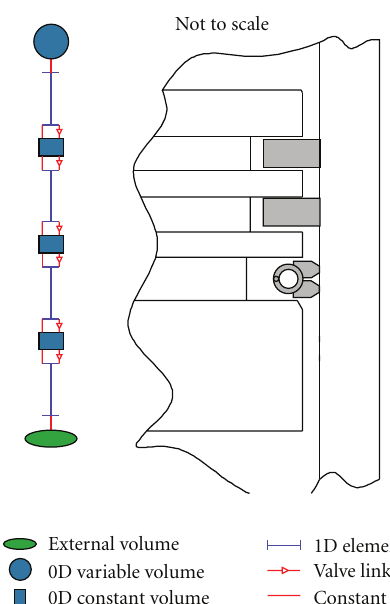
Figure 10: Axial forces on the segment.